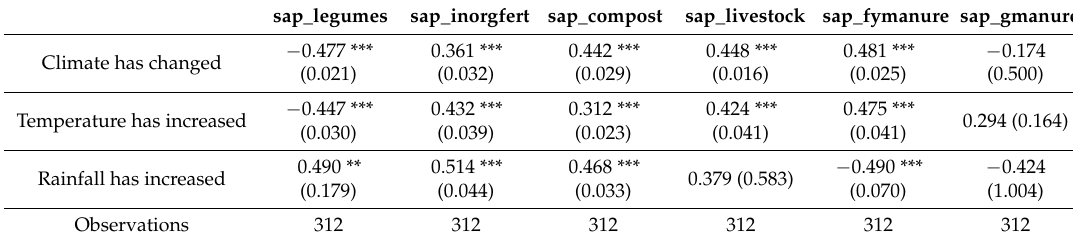
Table 3. The impact of climate change perceptions on the adoption of individual